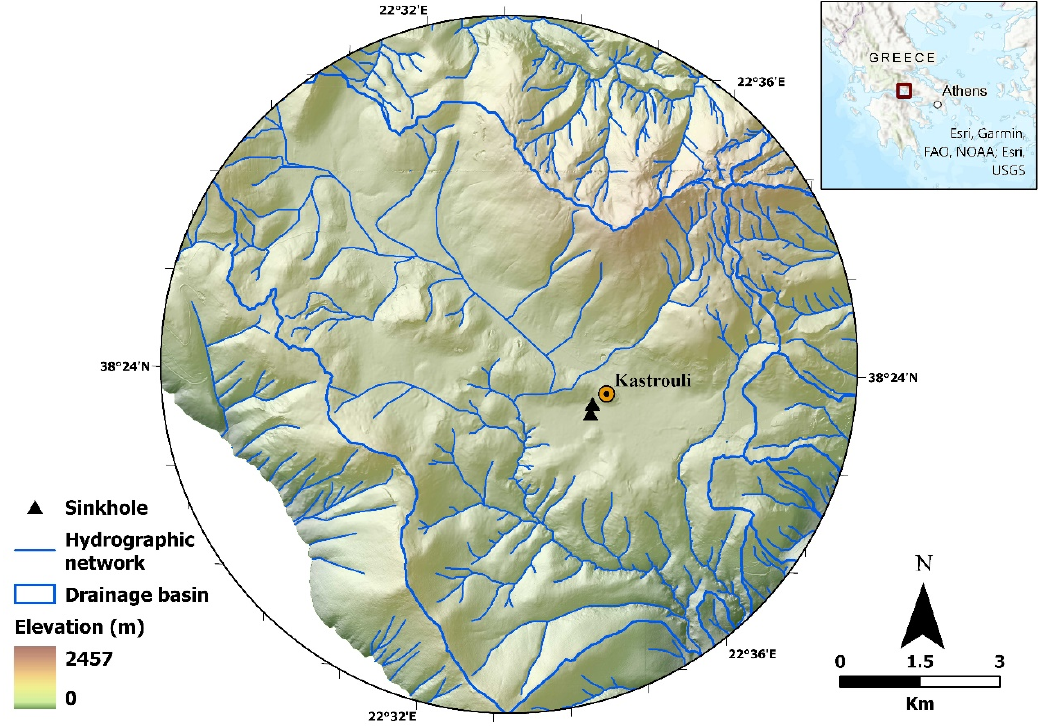
Figure 15. The well-developed hydrographic system of the wider Kastrouli area.